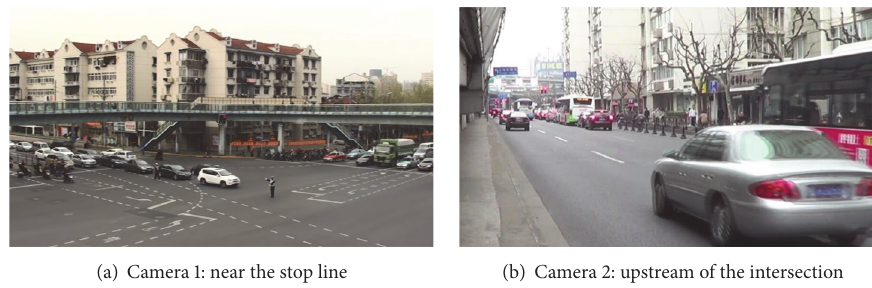
Figure 2: Examples of the camera views of the surveyed intersections.